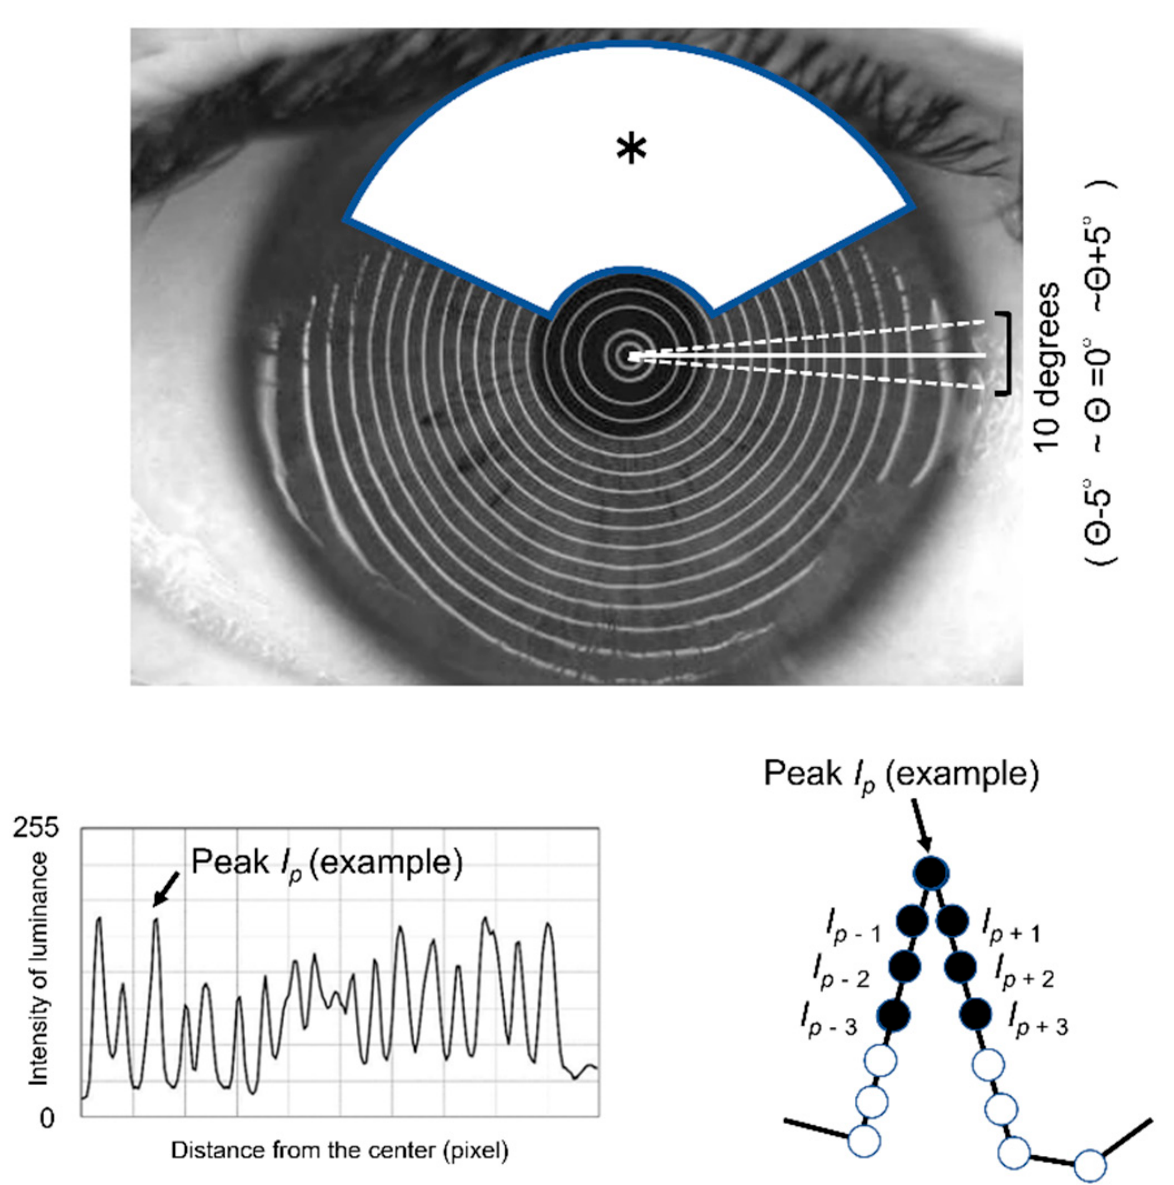
Figure 1. Images outlining the first step used for determining the blur value (BV) and disturbance value (DV) using a videokeratography (VK) instrument. Briefly, while tracking the center of the Meyer-ring (MR) image, the meridian extending from the center to the periphery of the cornea was determined for every 1 ◦ within a 10 ◦ ( θ − 5 ◦ ~ θ = 0 ◦ ~ θ + 5 ◦ ) unit (Figure 1, upper photo). Next, a graph indicating the relationship between the distance (pixel) from the center and the intensity of the luminance (0 ~ 255) was made (lower left image, a representative graph profile of the meridian at θ = 0 ◦ shown in the upper photo). From each intensity of luminance profile along each meridian within the 10 ◦ unit, the BV (an arbitrary unit) was then calculated using the formula described in the text after selecting the intensity of luminance at and around the peak (representative examples are shown in the lower left and right images). Due to the influence of the upper eyelid and eye lashes, an area from 30 ◦ to 150 ◦ external to the 5th ring (white area (*) in upper photo) were excluded from the